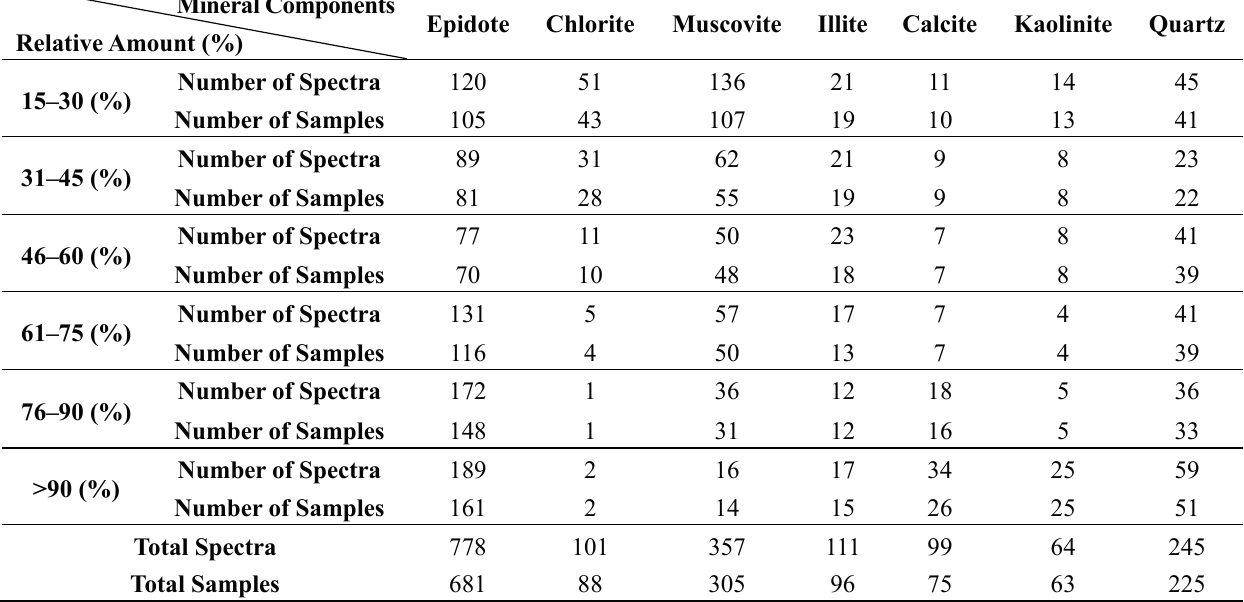
Table 4. Results of mineral identification and quantitative analysis obtained from the PIMA